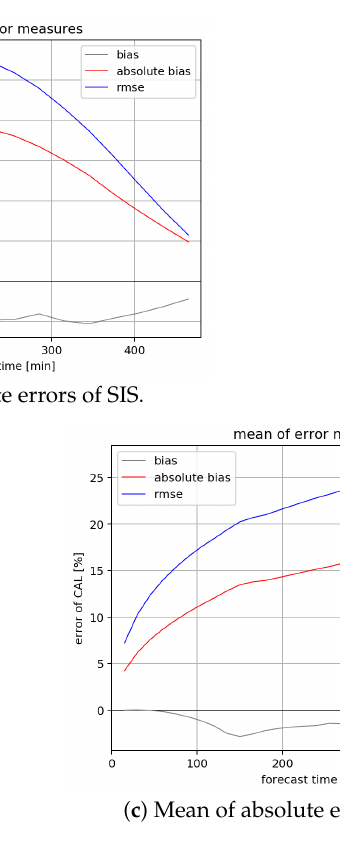
Figure 4. Plots of the mean error measures of all cases against forecast time for absolute ( a ) and relative errors ( b ) of SIS as well as the absolute errors of CAL ( c ). The validation of the solar surface irradiance was performed with SARAH-2 data by the CM SAF (Climate Monitoring Satellite Application Facility) and the validation of the effective cloud albedo was done with the effective cloud albedo